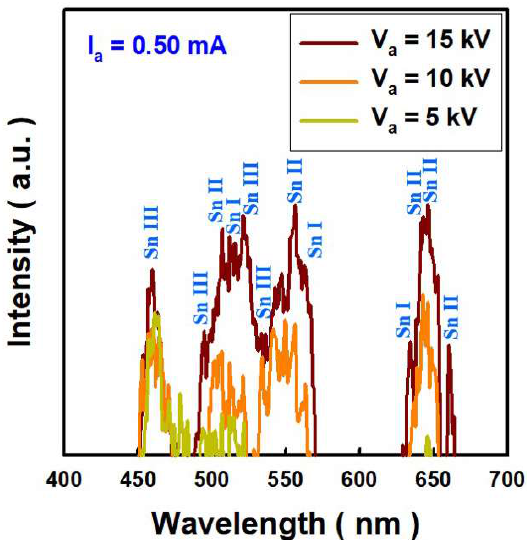
Figure 4. Visible light emission spectra of Sn target excited by cold cathode electrons irradiation. The light generated by electrons in the visible region is composed of neutral Sn (Sn І), single ionized Sn (Sn ІІ), and double ionized Sn (Sn ІІІ).